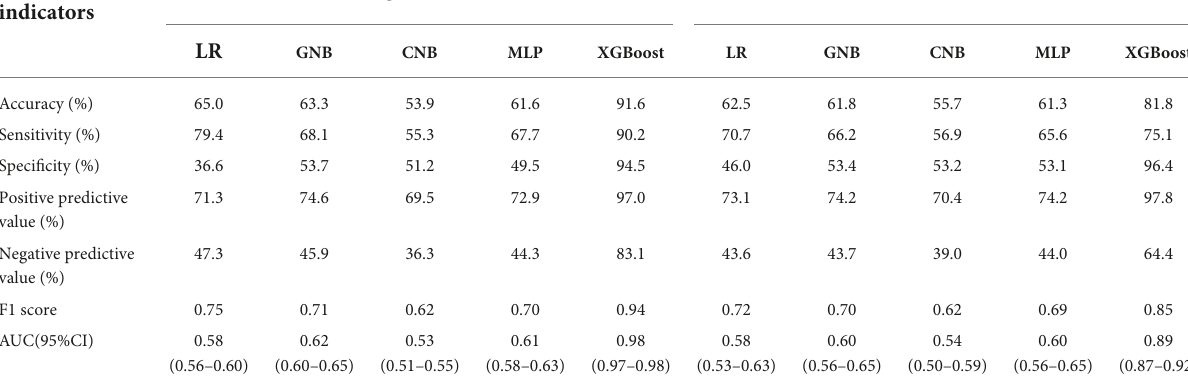
TABLE 3 Efficacy results for the five ML models.